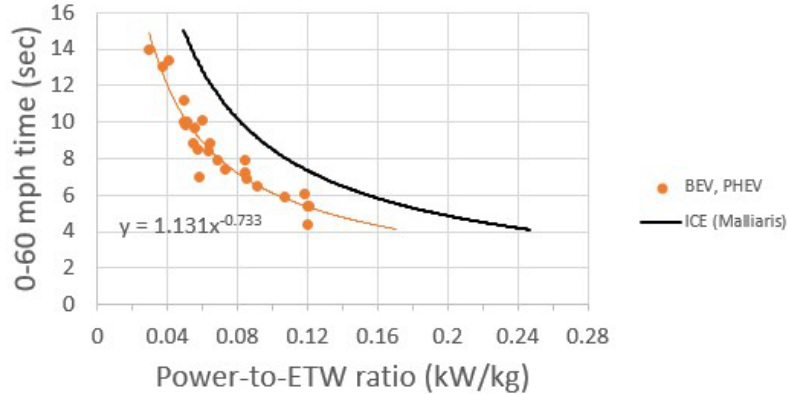
Figure 2. Relationship between peak-power-to-ETW ratio and acceleration performance for MY 2012–17 PEVs capable of pure electric acceleration.